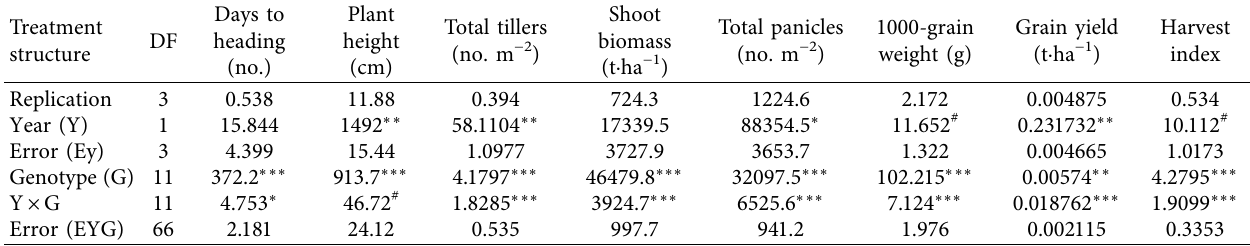
Table 1: Summary of analysis of variance for growth, yield components, and yield of rice as influenced by experimental year, genotype, and their interaction.